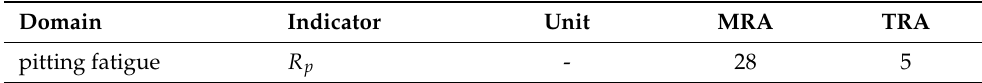
Table 2. Comparison of the indicator R p for MRA and TRA applications on VSR700 mission profiles. The indicator is evaluated over steady state flight phases (cruise).